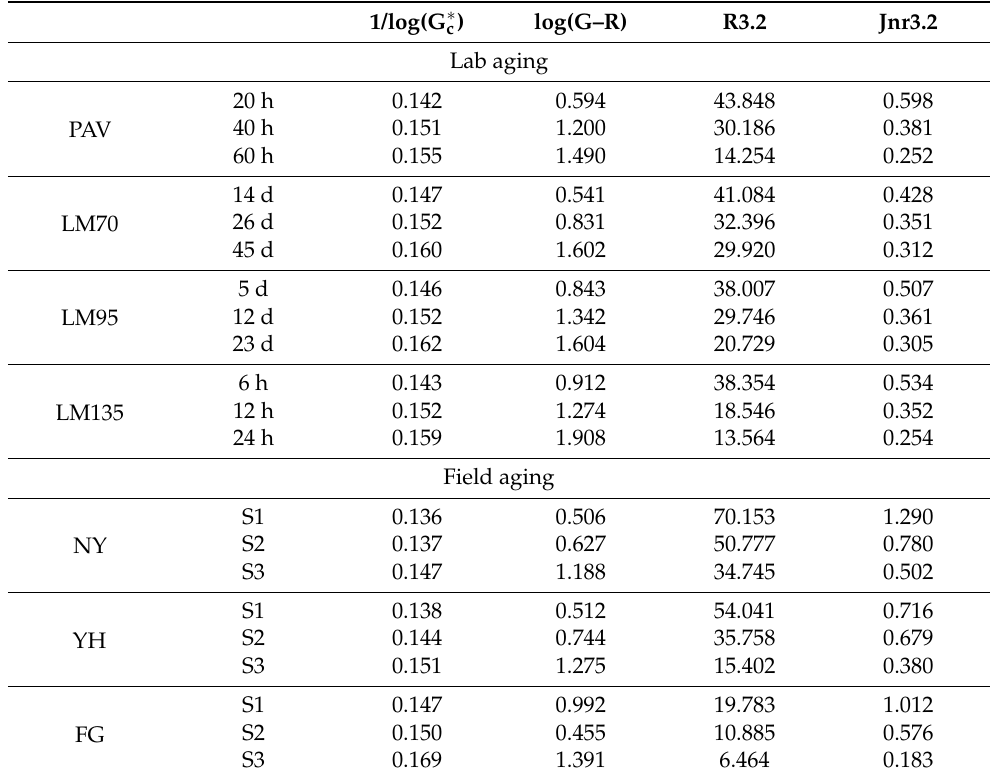
Figure 10. Correlation between V a and the rheological indices: ( a ) 1/log(G ∗ c ); ( b ) log(G–R); ( c ) R3.2; and ( d ) Jnr3.2. Table 4. Summary of rheological test